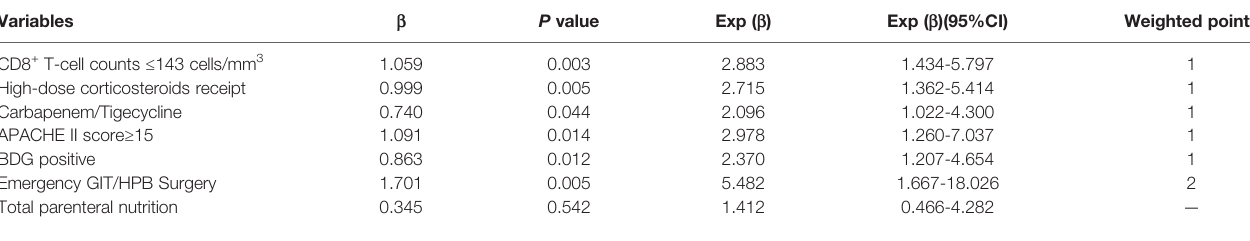
TABLE 2 | Multiple logistic regression model and weighted point